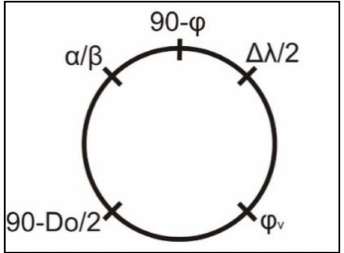
Figure 2. Napier wheel for great circle navigation